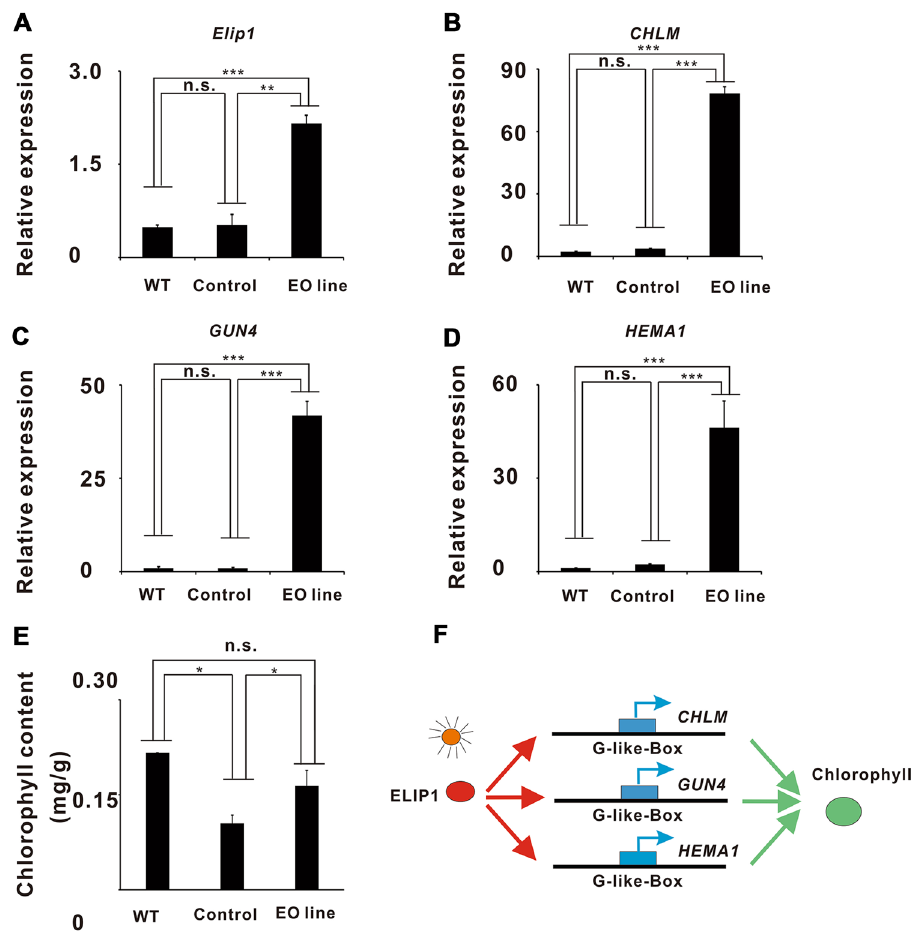
Figure 5. ELIP1 overexpression increased the expression levels of CHLM , GUN4 , and HEMA1 and chlorophyll content. ( A ) The expression of ELIP increased after the transfection of pBI121-ELIP1 vectors into Chinese cabbage leaves. ( B ) The expression of CHLM increased in the EO line. ( C ) The expression of GUN4 increased in the EO line. ( D ) The expressions of HEMA1 increased in the EO line. ( E ) Chlorophyll content of the EO line was higher than that of the control group, but the mean value was slightly lower than that of the WT group. ( F ) Model designed for chlorophyll regulation in postharvest Chinese cabbage. The ELIP1 protein regulated CHLM , GUN4, and HEMA1 via G-box-like motifs and affected chlorophyll biosynthesis during Chinese cabbage storage. EO line is the ELIP1 overexpression transgenic line, negative A. tumefaciens EHA105 colonies were used as the control, and “Beijing new No. 3” Chinese cabbage leaves were used as wild type (WT). Asterisks indicate a significant difference compared to control negative as analyzed by Dunnett, one-way ANOVA. (* p < 0.05; ** p < 0.01; *** p < 0.001). All error bars are expressed as